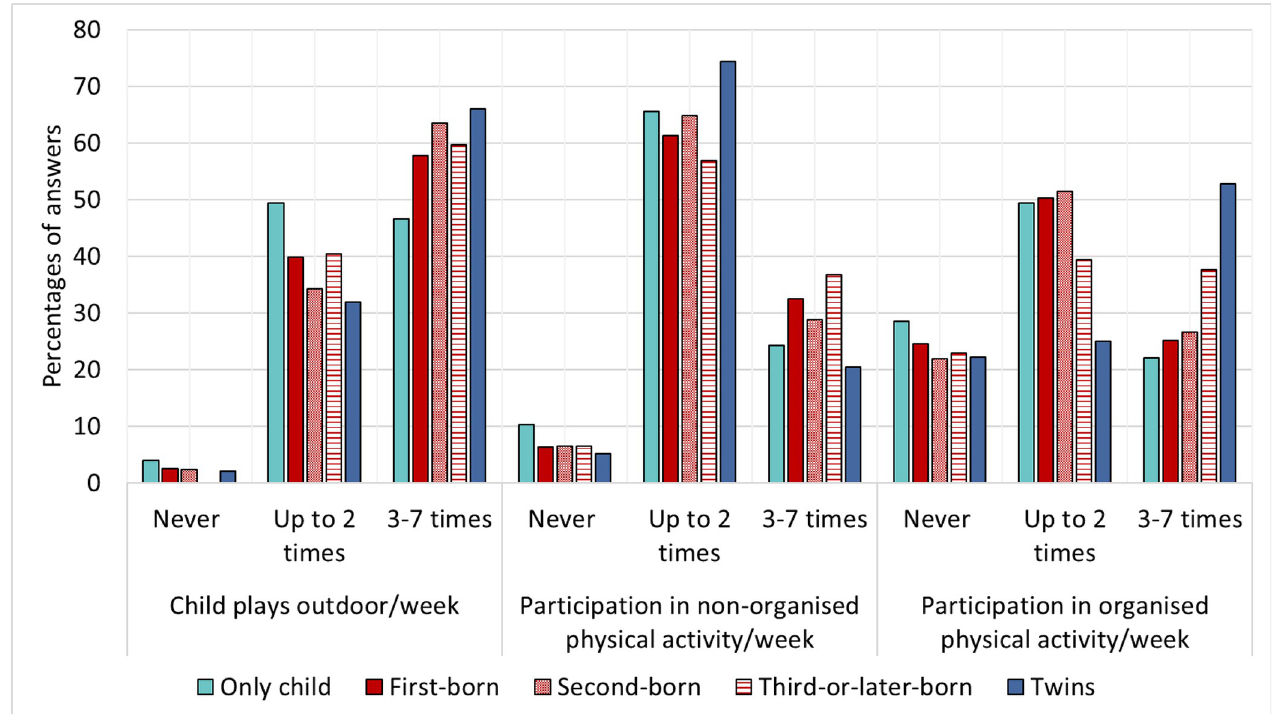
Fig 6. Assessment of physical activity in three categories by sibling status. The graph shows the percentage of children per sibling status selecting the three activity categories “Child plays outdoor”, “Participation in non-organised physical activity” and “Participation in organised physical activity”. The answer categories were aggregated into three groups: 1) Never, 2) Up to 2 times/week and 3) 3–7 times/week.